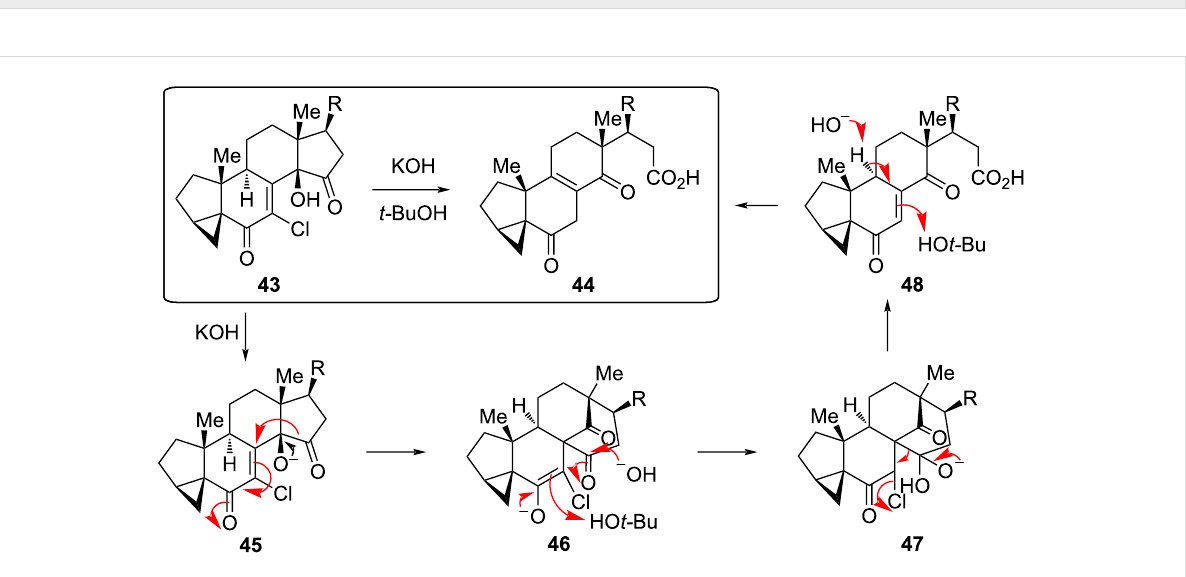
Figure 11: Tandem reaction of strophasterol A synthetic intermediate 43 to 44 through a vinylogous α -ketol rearrangement of 45 to 46